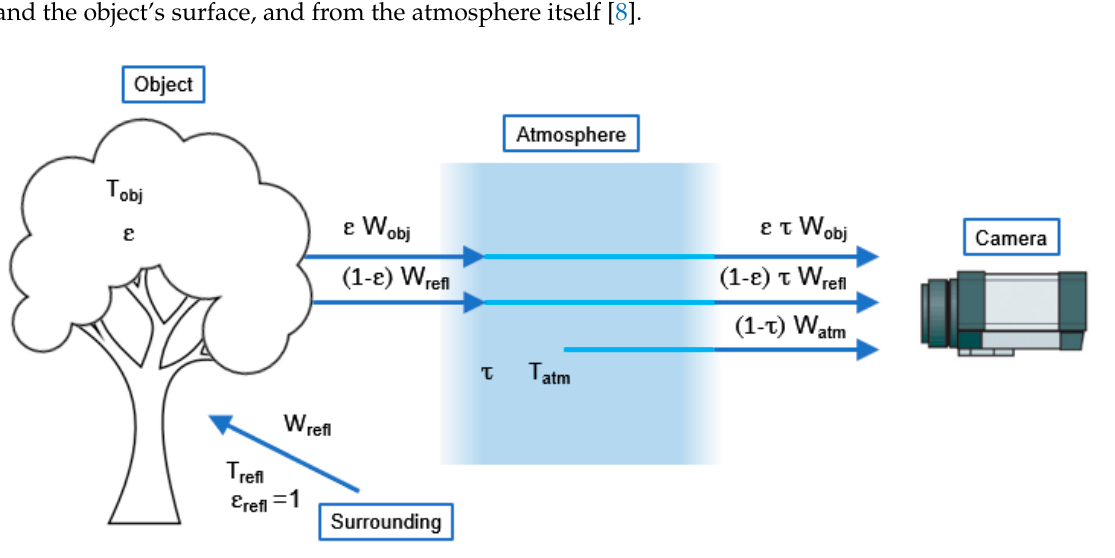
Figure 1. Schematic representation of a generic thermographic measurement (adapted from [8]).